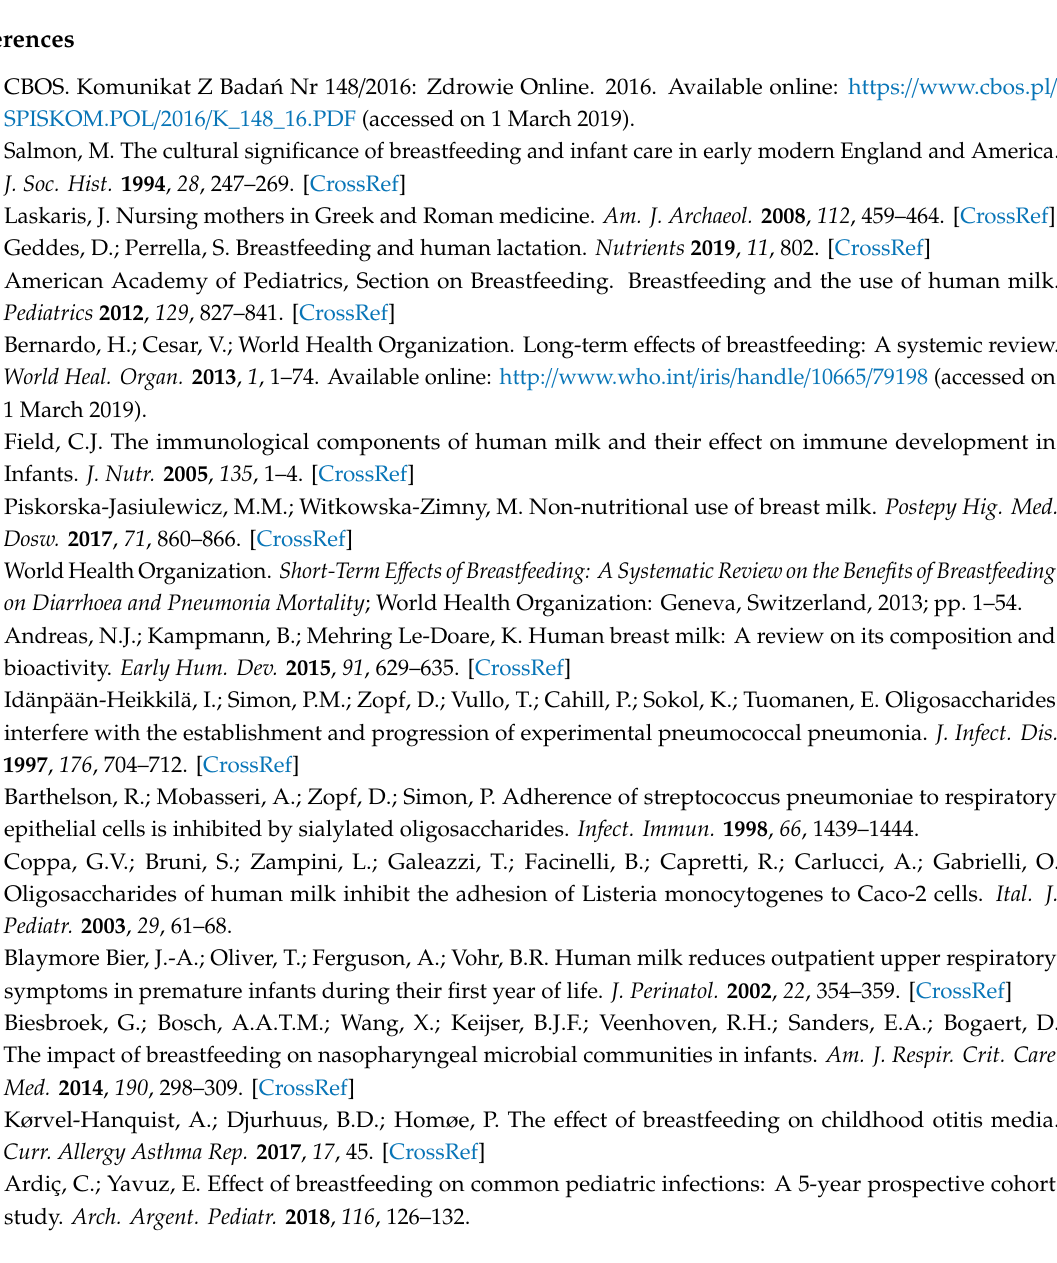
Figure S1: Introduction and conclusion of the online form used for the survey. A copy of the pre-filled form is available online: https: // docs.google.com / forms / d / e / 1FAIpQLSewcxKIW39bsUz46dBC6GNXfhXtmSNPowPDniNDpdKbRGq- jw /